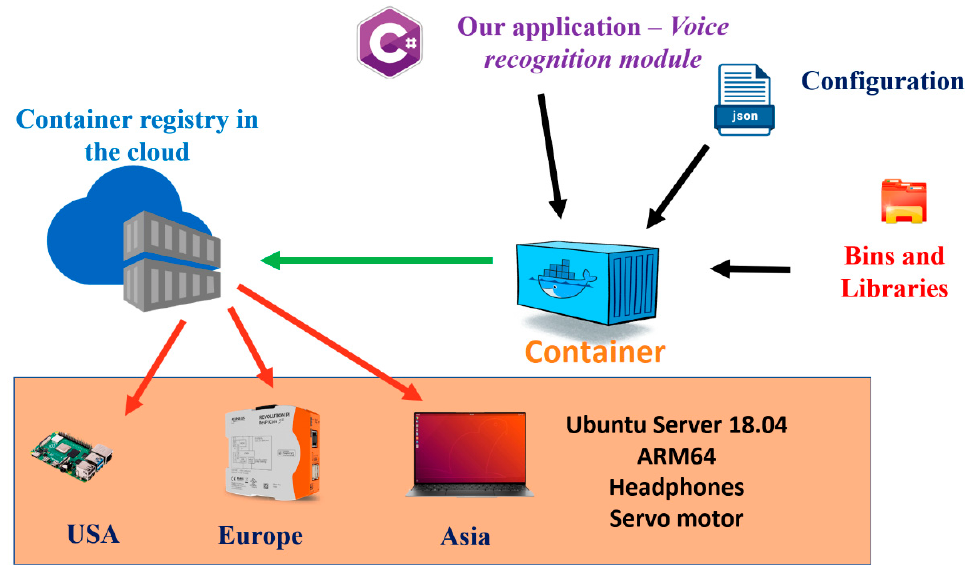
Figure 2. Packing of all dependencies to the container and the following distribution of the container to different machines around the world.